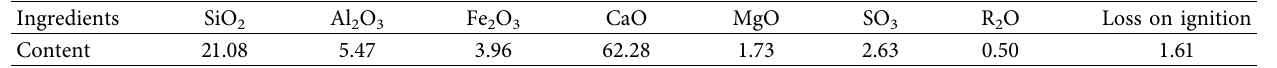
Table 1: Chemical composition of cement (mass